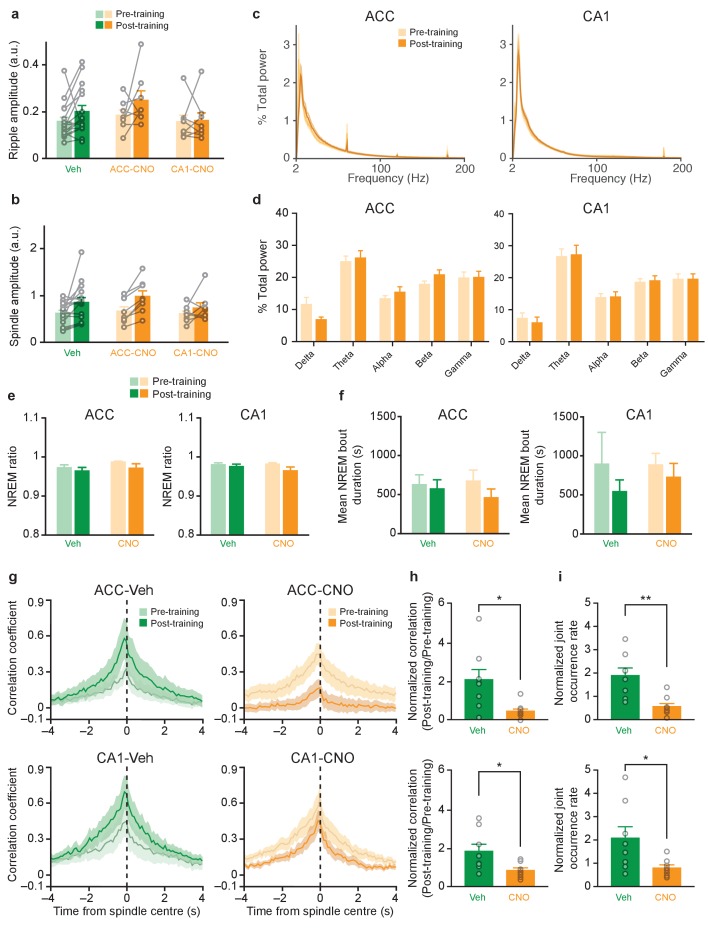
Inhibition of PV+cells in ACC or CA1 does not alter ripple or spindle amplitude, induce seizures, or alter sleep architecture, but impairs learning-induced increase in ripple-spindle coupling.CNO administration (compared to Veh administration) to mice micro-infused with hM4Di-mCherry in ACC or CA1 region of dorsal hippocampus did not alter (a) ripple amplitude (Veh n = 16, ACC-CNO n = 8, CA1-CNO n = 8; two-way repeated measures ANOVA pre-training versus post-training x Veh versus ACC-CNO versus CA1-CNO; pre-training versus post-training F1,29 = 13.42, p=0.001; Veh versus ACC-CNO versus CA1-CNO F2,29 = 0.63, p=0.54; interaction F2,29 = 0.64, p=0.54), or (b) spindle amplitude (Veh n = 16, ACC-CNO n = 8, CA1-CNO n = 8; Kruskal-Wallis test Veh versus ACC-CNO versus CA1-CNO p=0.056; Wilcoxon signed rank test pre-training versus post-training p=0.027). No differences in (c) power spectrum (between 2–200 Hz) before (pre-training) and after (post-training) CNO treatment in mice micro-infused with virus in ACC (left, % total ACC power, n = 8) or CA1 (right, % total CA1 power, n = 8), or (d) % total power (between 1–100 Hz) as quantified from (c), in delta (1–4 Hz), theta (4–12 Hz), alpha (12–20 Hz), beta (20–40 Hz) or gamma (40–100 Hz) frequency bands in mice micro-infused with hM4Di-mCherry virus in ACC (left, two-way repeated measures ANOVA pre-training versus post-training x five frequency bands; pre-training versus post-training F1,7 = 0.47, p=0.52; frequency bands F4,28 = 17.88, p<0.0001; interaction pre-training versus post-training x frequency bands F4,28 = 1.74, p=0.17), or CA1 (right, two-way repeated measures ANOVA pre-training versus post-training x five frequency bands; pre-training versus post-training F1,7 = 0.001, p=0.97; frequency bands F4,28 = 16.30, p<0.0001; interaction F4,28 = 0.64, p=0.64). No differences in Veh- or CNO-treated mice micro-infused with virus in ACC or CA1 in (e) non-REM (NREM) ratio during recording sessions, (ACC, left, n = 8 per group; two-way repeated measures ANOVA pre-training versus post-training x Veh versus CNO; pre-training versus post-training F1,14 = 3.46, p=0.084; Veh versus CNO F1,14 = 1.12, p=0.31; interaction F1,14 = 0.40, p=0.55; CA1, right, n = 8 per group; Mann-Whitney test p=0.84, Wilcoxon signed-rank test Veh pre-training versus post-training p=0.74, CNO pre-training versus post-training p=0.55), or (f) NREM bout duration (ACC, left, n = 8 per group; Mann-Whitney test p=0.15, Wilcoxon signed-rank test Veh pre-training versus post-training p>0.99, CNO pre-training versus post-training p=0.55; CA1, right, n = 8 per group; Mann-Whitney test p=0.75, Wilcoxon signed-rank test Veh pre-training versus post-training p=0.95, CNO pre-training versus post-training p=0.38). (g) Learning-induced increases in cross-correlation between spindle and ripple events in Veh-treated mice micro-infused with hM4Di-mCherry in ACC or CA1 was prevented in CNO-treated mice. (h) Pre-training-normalized peak correlation coefficients in mice micro-infused with virus in ACC (n = 8 per group; Welch’s t-test t8.07 = 2.46, p=0.023; Veh versus one one-sample t-test t7 = 1.93, p=0.095; CNO versus one one-sample t-test t7 = 3.49, p=0.01), or CA1 (n = 8 per group; Welch’s t-test t8.73 = 2.49, p=0.036; Veh versus one one-sample t-test t7 = 2.18, p=0.066; CNO versus one one-sample t-test t7 = 1.29, p=0.24). (i) Pre-training-normalized ripple-spindle joint occurrence rate in mice micro-infused with virus in ACC (n = 8 per group; Welch’s t-test t9.66 = 3.67, p=0.005; Veh versus one one-sample t-test t7 = 2.66, p=0.033; CNO versus one one-sample t-test t7 = 3.05, p=0.020), or CA1 (n = 8 per group; Welch’s t-test t7.88 = 2.35, p=0.047; Veh versus one one-sample t-test t7 = 2.08, p=0.077; CNO versus one one-sample t-test t7 = 1.40, p=0.21). Data are individual mouse, or mean ±s.e.m. (a.u.: arbitrary unit, *p<0.05, **p<0.01).